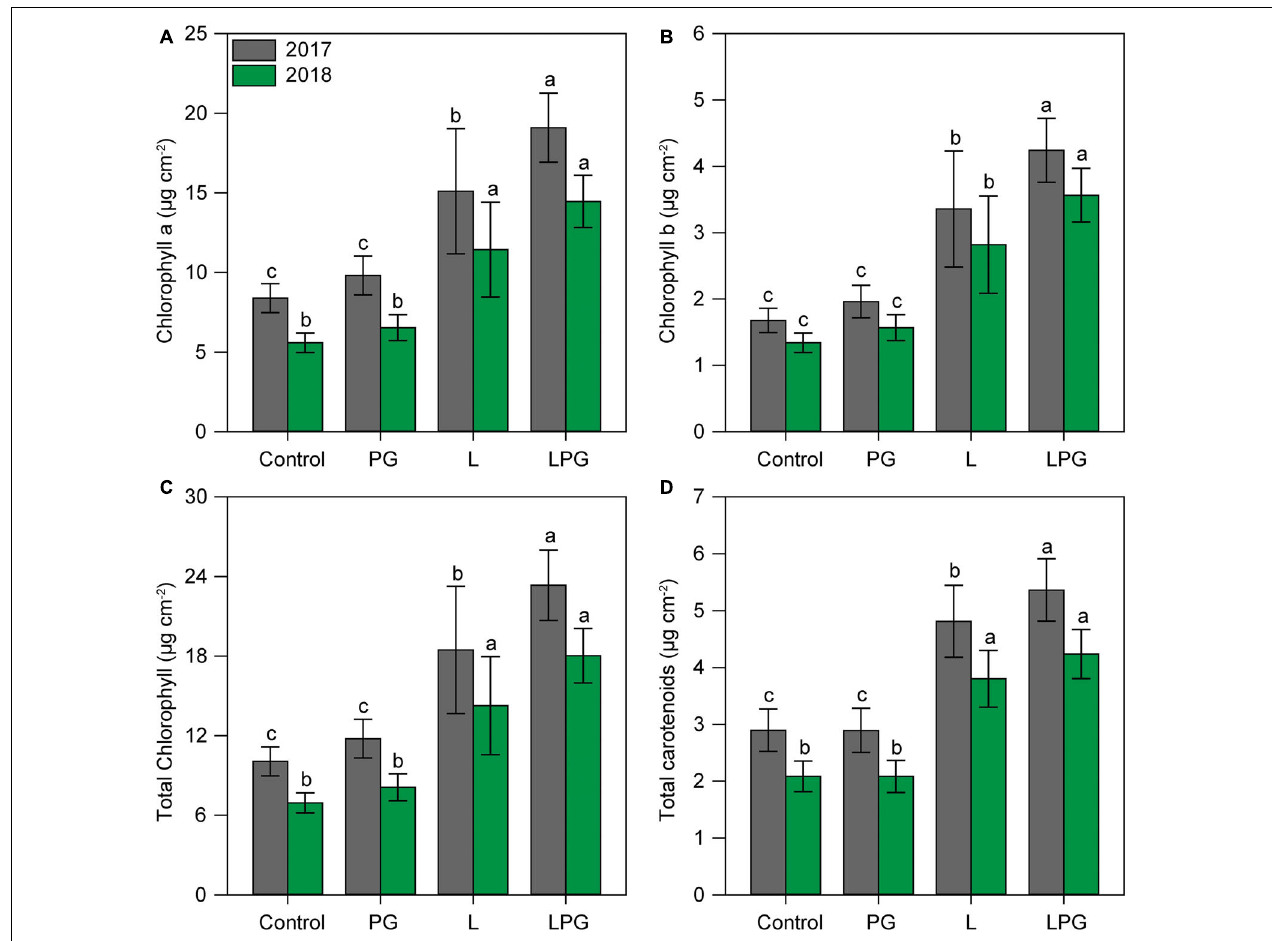
FIGURE 5 | Chlorophyll a (A) , chlorophyll b (B) , total chlorophyll (C) , and carotenoids (D) contents in maize leaves as affected by surface-applied lime (L), phosphogypsum (PG), and lime + phosphogypsum (LPG) treatments. Different lower-case letters indicate significant differences between treatments for each growing season by Student’s t -test at p ≤ 0.05. Error bars express the standard error of the mean ( n =